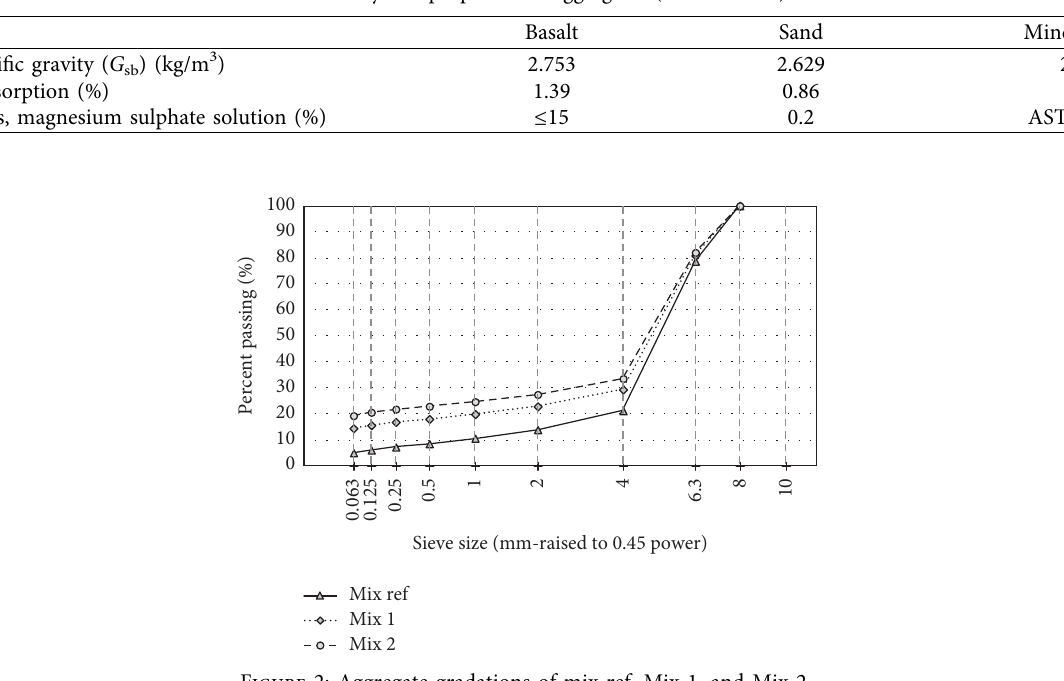
Figure 1: Gradation of rubber particles. Table 1: Physical properties of aggregates (EN 1097-6/7).